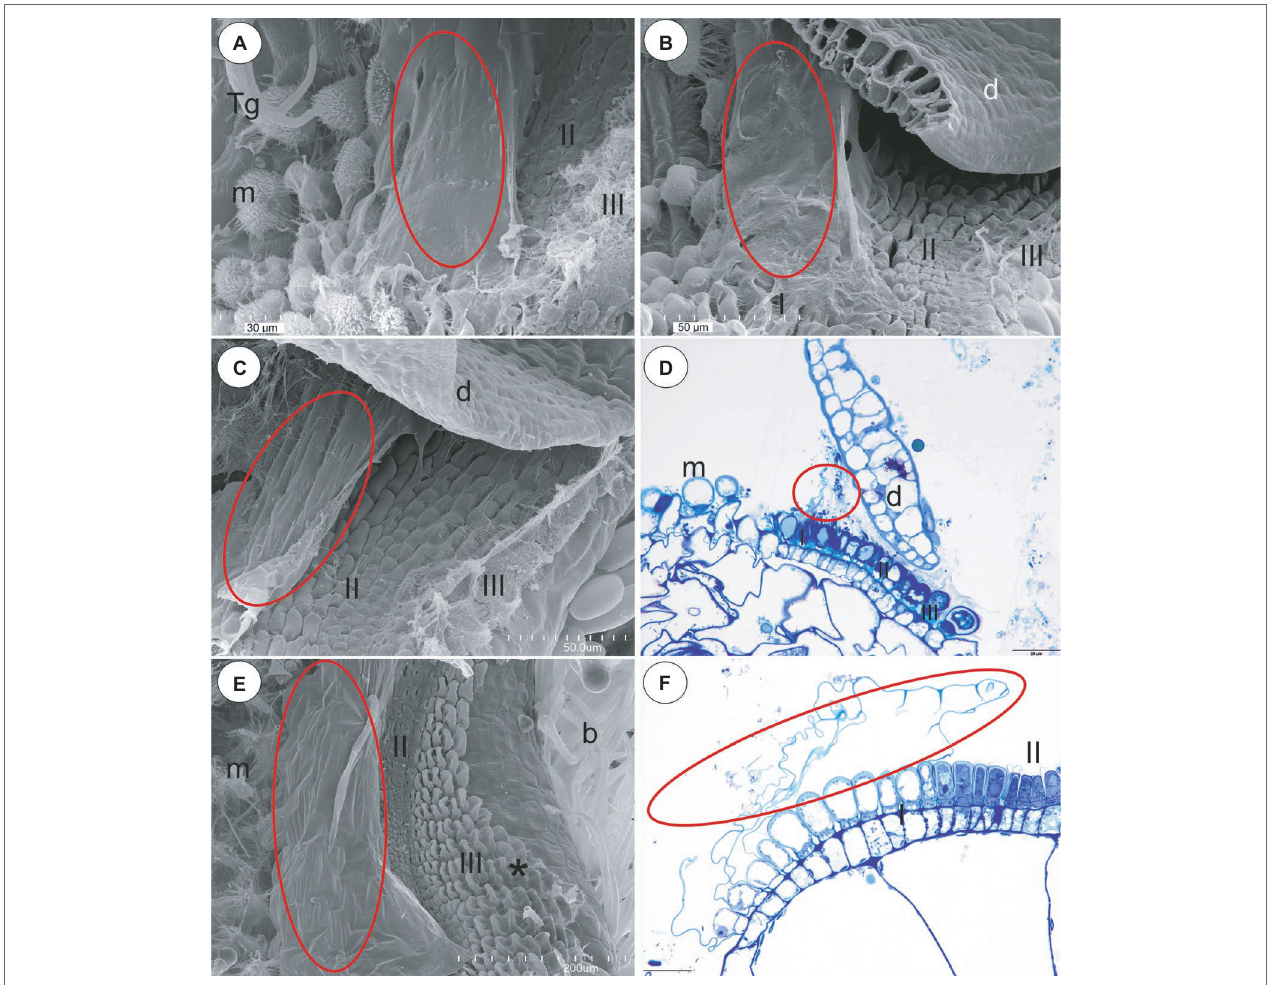
FIGURE 6 | Structure of the pavement epithelium and velum of Utricularia species; section Orchidioides ( Utricularia alpina , Utricularia nelumbifolia , Utricularia humboldtii ) and section Utricularia ( U. reflexa ). (A) Utricularia alpina , SEM image of the pavement epithelium, note the velum that covers zone one (ellipse), the middle zone (II) and the internal zone (III) with the mucilage trichomes and the sessile mucilage trichomes at the front of the pavement epithelium (m), trigger bristles (Tg); scale bar = 30 μ m. (B) Utricularia humboldtii , SEM image of the pavement epithelium, note the velum (ellipse), zone one (I), the middle zone (II) and the internal zone (III) with the mucilage trichomes and the sessile mucilage trichomes at the front of the pavement epithelium (m), door (d); scale bar = 50 μ m. (C) Utricularia nelumbifolia , SEM image of the pavement epithelium, note the velum that covers zone one (ellipse), the middle zone (II) and the internal zone (III) with the mucilage trichomes, trap door (d); scale bar = 50 μ m. (D) Utricularia nelumbifolia , a semi-thin longitudinal section of the pavement epithelium, note the three zones of the pavement epithelium (I, II, III), the velum (circle), trap door (d), the mucilage trichomes (m); scale bar = 20 μ m. (E) Utricularia reflexa, SEM image of the pavement epithelium, note the velum (ellipse), the middle zone (II) and the internal zone (III) with the mucilage trichomes (asterisk) and the mucilage trichomes at the front of the pavement epithelium (m), bifids (b); scale bar = 200 μ m. (F) Utricularia reflexa , a semi-thin longitudinal section of part of the pavement epithelium, note the zones of pavement epithelium (I, II), the velum (ellipse); scale bar = 20 μ